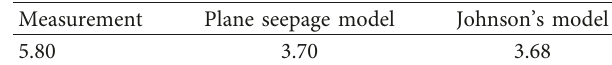
Table 3: Settlement of modified Chai’s model (mm).